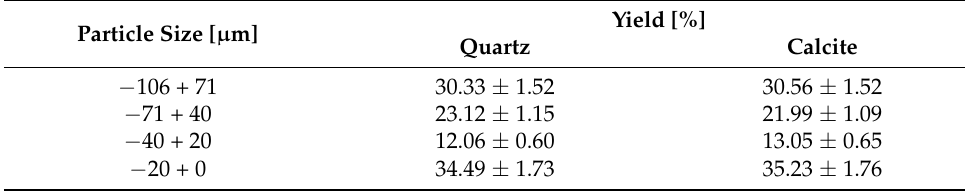
Table 8. Particle size distribution of calcite and quartz.